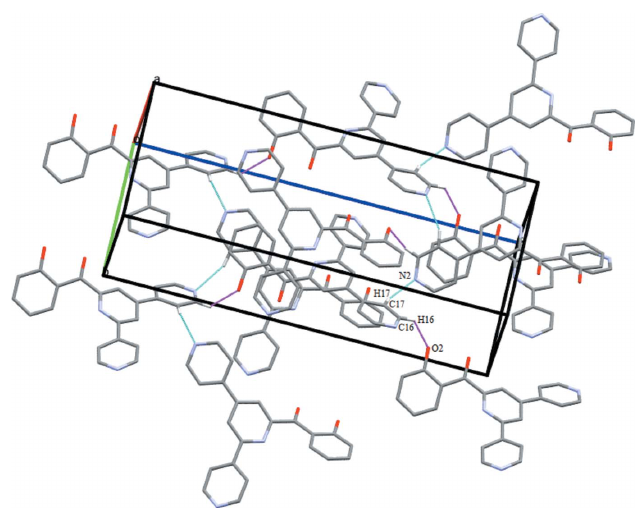
Figure 3 Unit-cell packing of the title compound showing intermolecular C— H (cid:3)(cid:3)(cid:3) N and C—H (cid:3)(cid:3)(cid:3) O interactions as dotted lines. H atoms not involved in hydrogen bonding have been excluded.